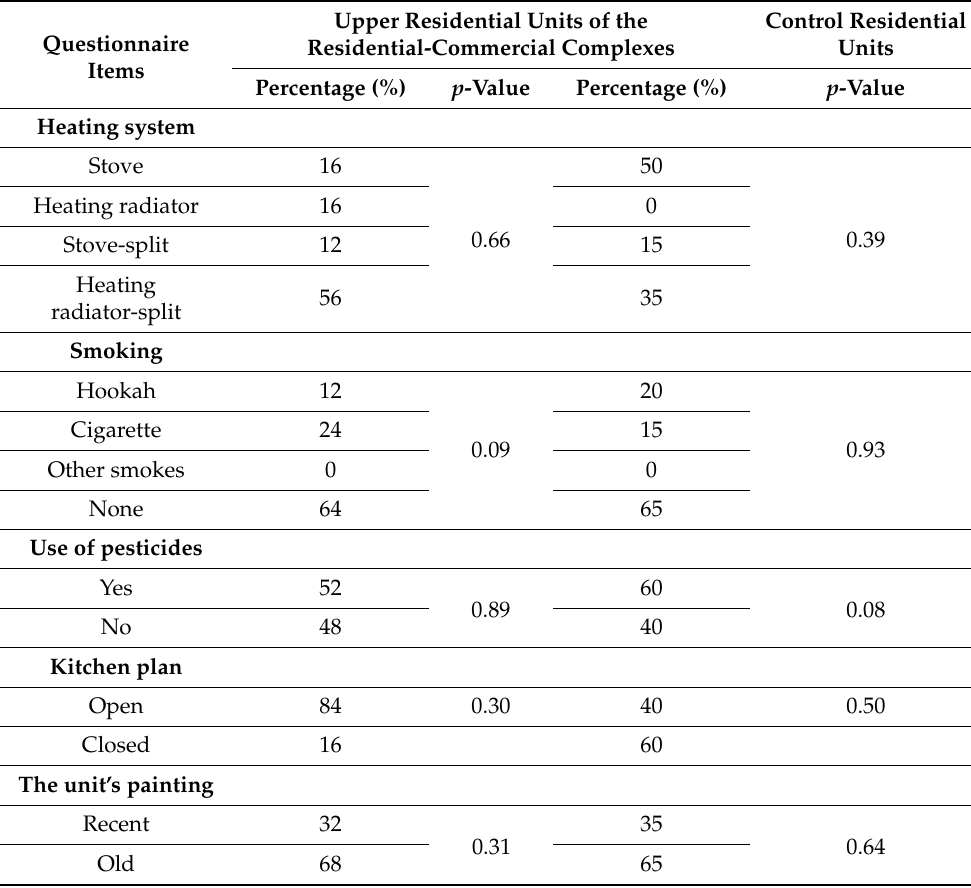
Table 4. Descriptive statistics of the questionnaire